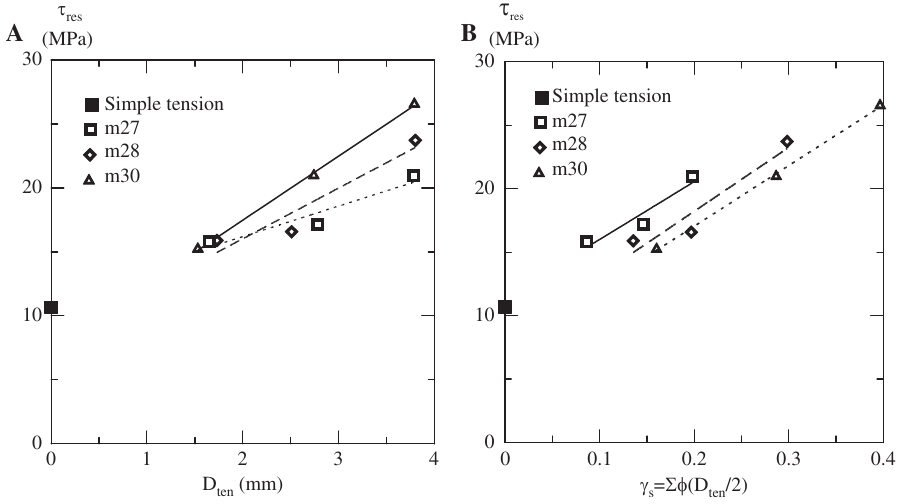
Figure 3 Single < 100 > crystals of series 2 (Cu-1.35 wt % Mn). The diameter of the specimens in torsion is approximately 3.8 mm. The specimens are subjected to forward and backward torsion with an amount of twist of four times 7.5 ° /cm for specimen m27, six times 7.5 ° /cm for specimen m28, and eight times 7.5 ° /cm for specimen m30. (A) Variation of the critical resolved shear stress measured in tension for different diameters D (B) Respective critical resolved shear stress dependence on the prior total surface